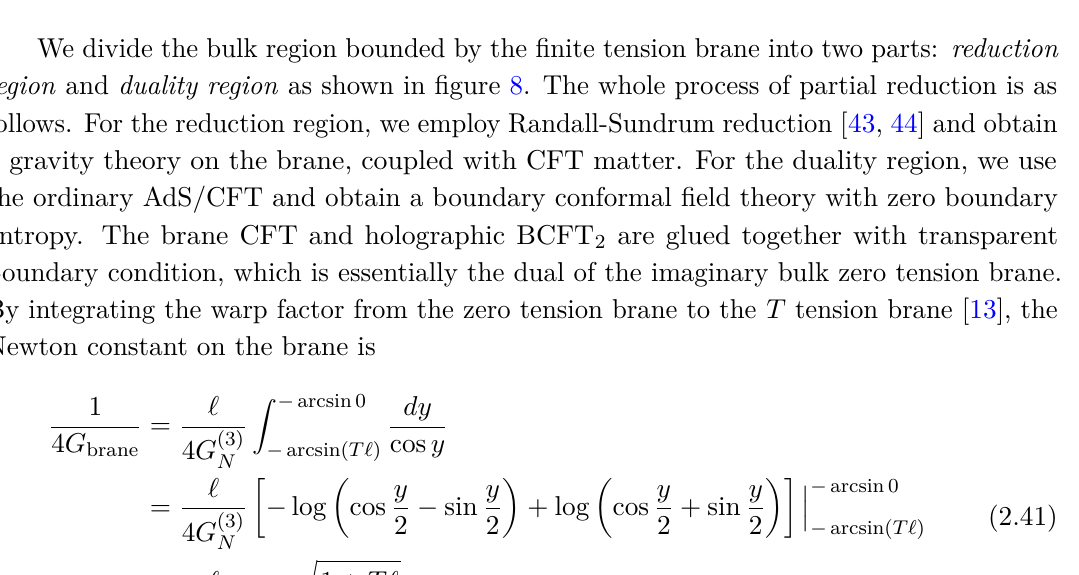
Figure 8 . The bulk region is divided into two parts by the zero tension brane. A 2 d effective theory is obtained by applying partial Karch-Randall and AdS/CFT to reduction region and dual region